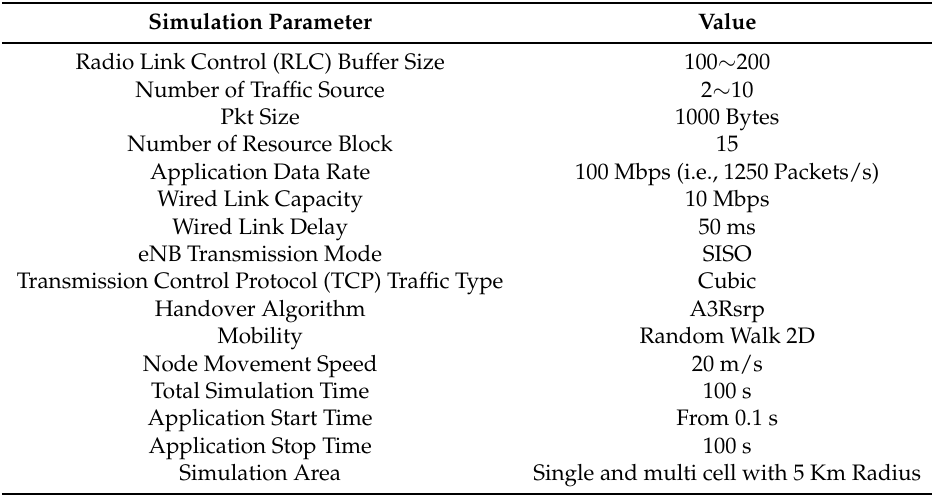
Table 1. Different Simulation Parameters in